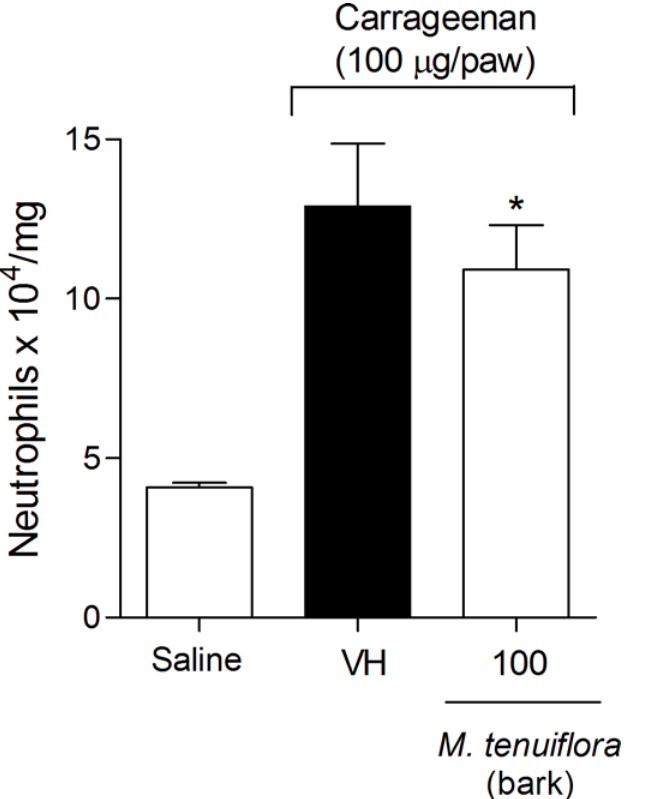
Fig 9. Effect of the ethanolic extract of M . tenuiflora bark on the inflammatory nociception association with the Cg-induced migration of neutrophils into the plantar tissue evaluated by determining myeloperoxidase activity (MPO). VH is the vehicle group (negative control). The ethanolic extract of M . tenuiflora bark was tested at the dose of 100 mg/kg (s.c.). The results are presented as the mean ± S.D. (n = 8). Statistical significance was calculated by ANOVA followed by Bonferroni's test. * P < 0.05 compared to the vehicle-negative control treated